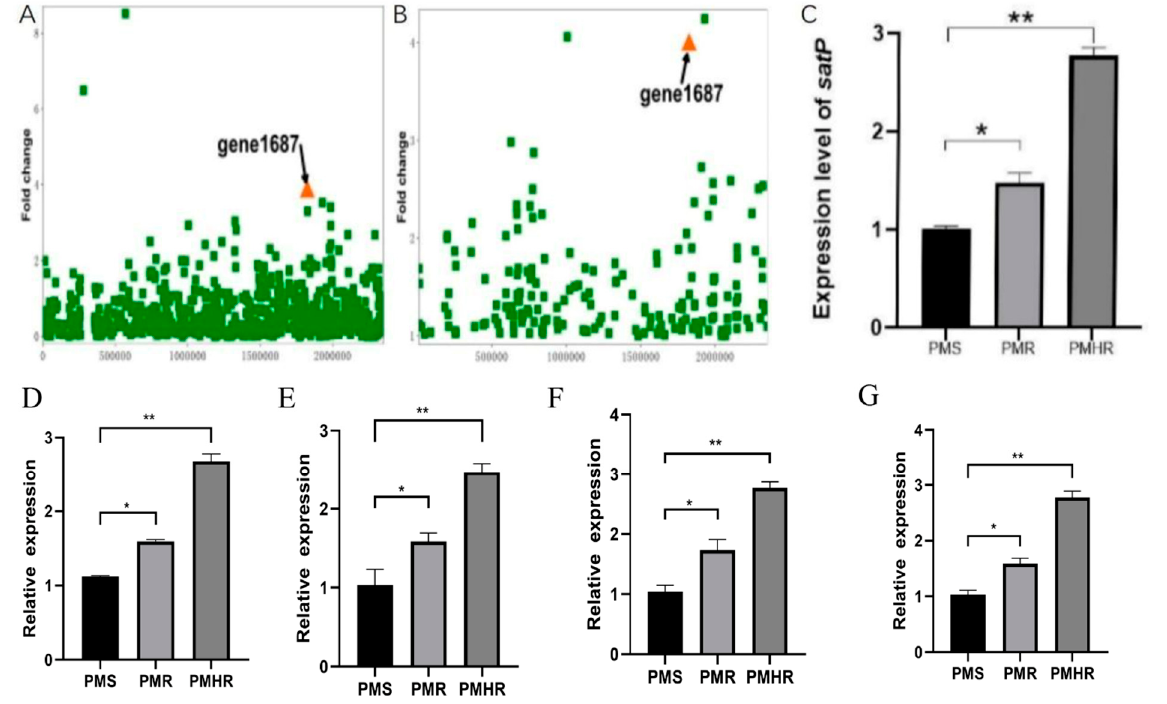
Figure 1. Characterization and verification of differentially expressed genes. ( A ) Differentially expressed gene analysis of resistance groups ( PmS vs. PmR ). ( B ) Differentially expressed gene analysis of resistance groups ( PmS vs. PmHR ). ( C ) satP , ( D ) focA , ( E ) napF , ( F ) glgP and ( G ) napD gene expression level verification using qRT-PCR. (All data are expressed as the mean ± SD. n = 3. ∗∗ p < 0.01 vs., ∗ p < 0.05 vs. control group).